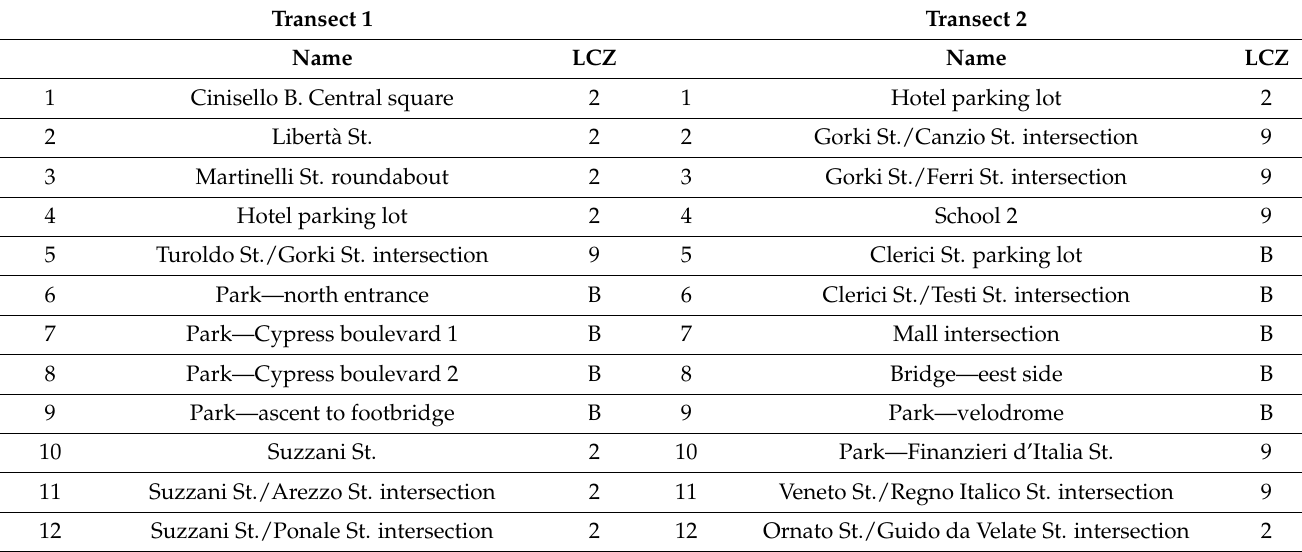
Figure 2. ( a , b ) Location of Parco Nord in the context of the urban area of Milan. ( c ) Transects of the bike monitoring activity (transect 1—red line, transect 2—blue line). Table 2. Transect check points with LCZ classification.